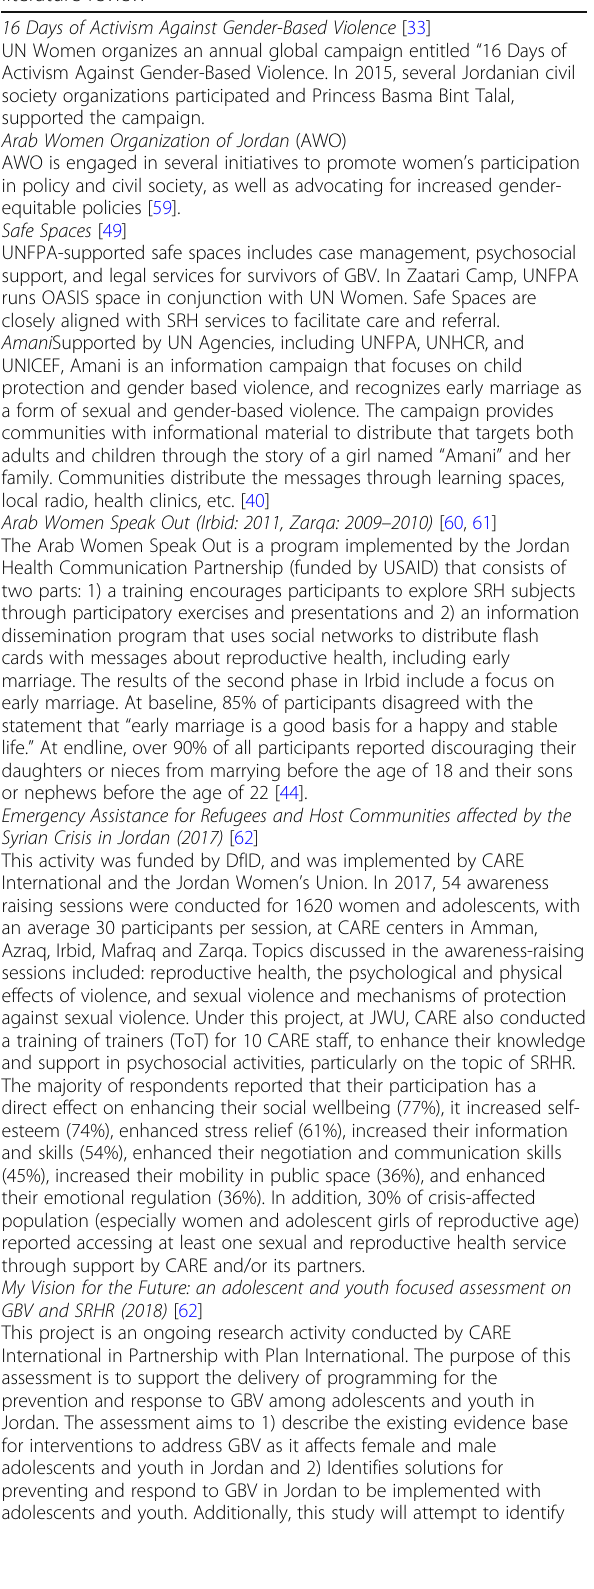
Table 2 Summary of programs focused on sexual and gender- based violence (SGBV) in Jordan since 2008 retrieved in literature review